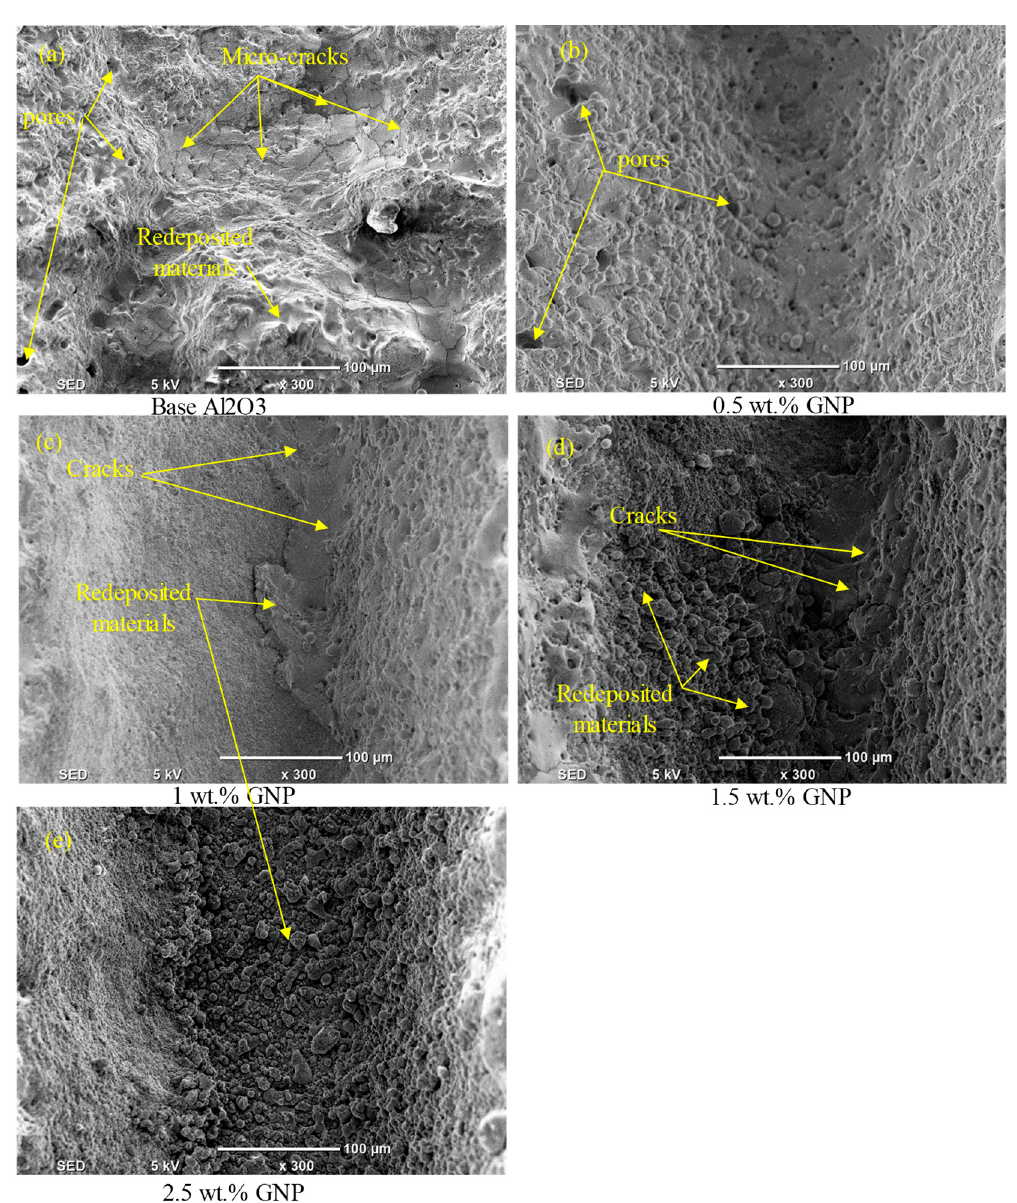
Figure 10. Zoomed-in images of the selected regions (1–5) shown in Figure 9.